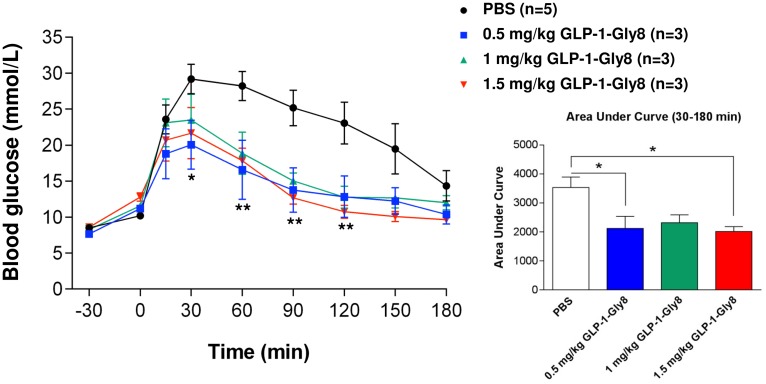
Bioactivity of GLP-1-Gly8 injected subcutaneously using IPGTT.Blood glucose levels in the intraperitoneal glucose tolerance test (IPGTT) in GK rats. GLP-1-Gly8 was given subcutaneously at 0.5 mg/kg (blue), 1 mg/kg (green) or 1.5 mg/kg (red) body weight 30 min prior to the glucose challenge test (Glucose: 2 g/kg of body weight). The area under the curve (AUC) for glucose levels corresponding to 30–180 min is shown. Data are presented as the mean ± SEM (PBS group n = 5, others n = 3). **p<0.01, *p<0.05 versus PBS.